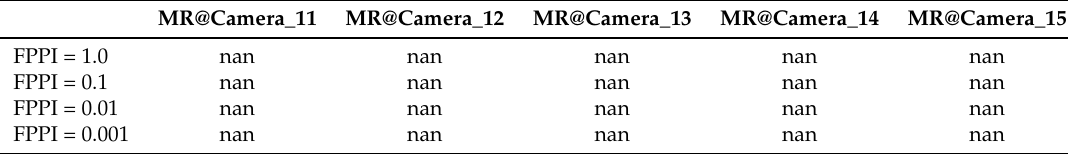
Table 9. Accuracy table @ Cameras_11–15, YOLOv3.